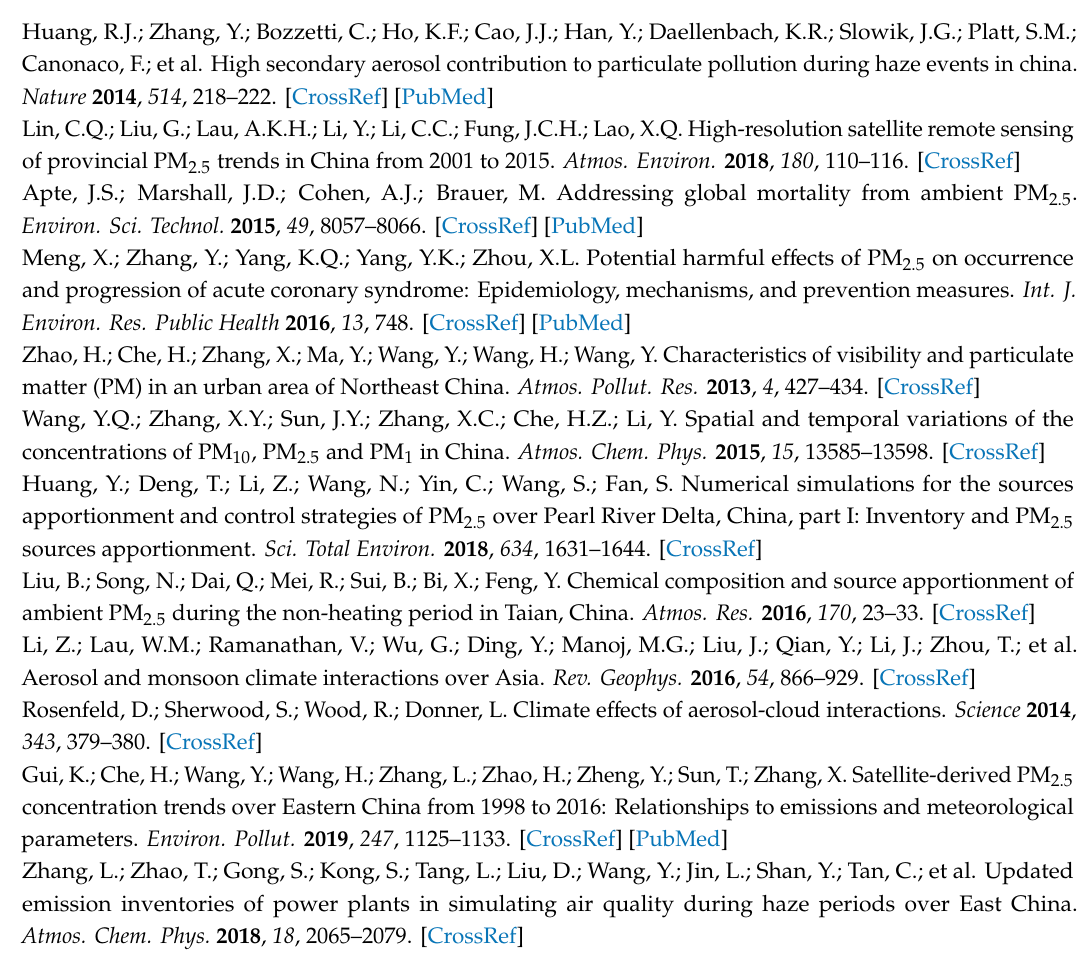
Figure S1: Vertical distribution of di ff erence of PM 2.5 flux averaged over the THB during the air pollution event in real terrain and changed terrain simulations; Figure S2: Vertical distribution of temperature averaged over the THB during the air pollution event in real terrain (E1; black dotted line) and changed terrain (E3; red dotted line) simulations; Table S1: PM 2.5 change and terrain contribution based on the E1 and E3 simulations; Table S2: Terrain contribution to regional transport of PM 2.5 and local